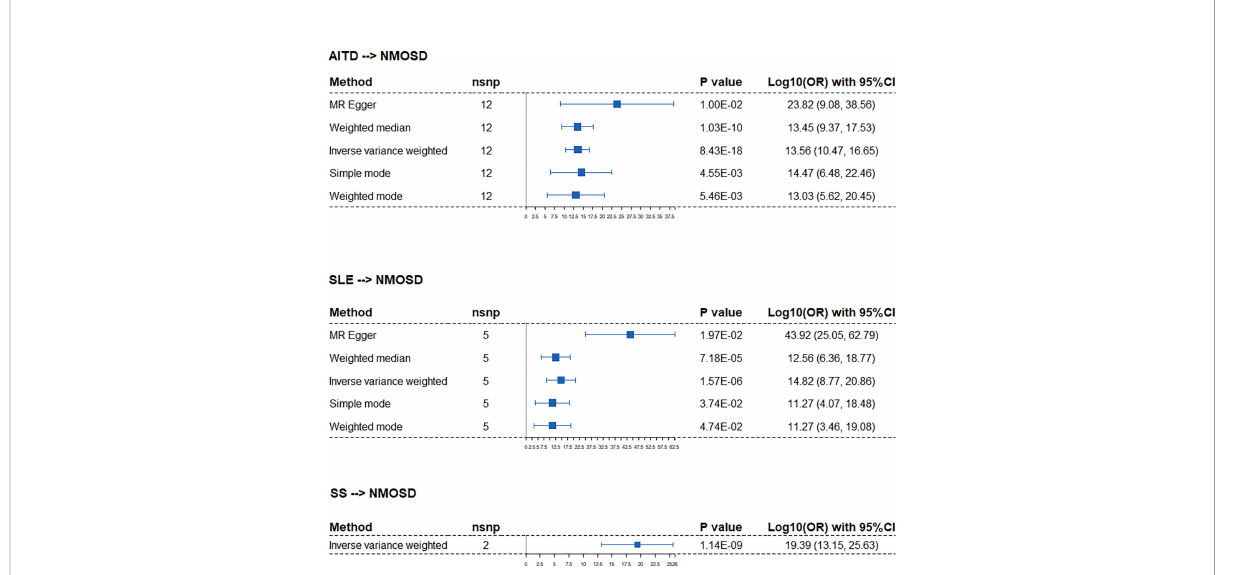
FIGURE 2 Forest plots of Mendelian randomization analysis that estimates the risk of NMOSD on the exposure of AITD, SLE, and SS. nsnp, number of causal SNPs; CI, con fi dence